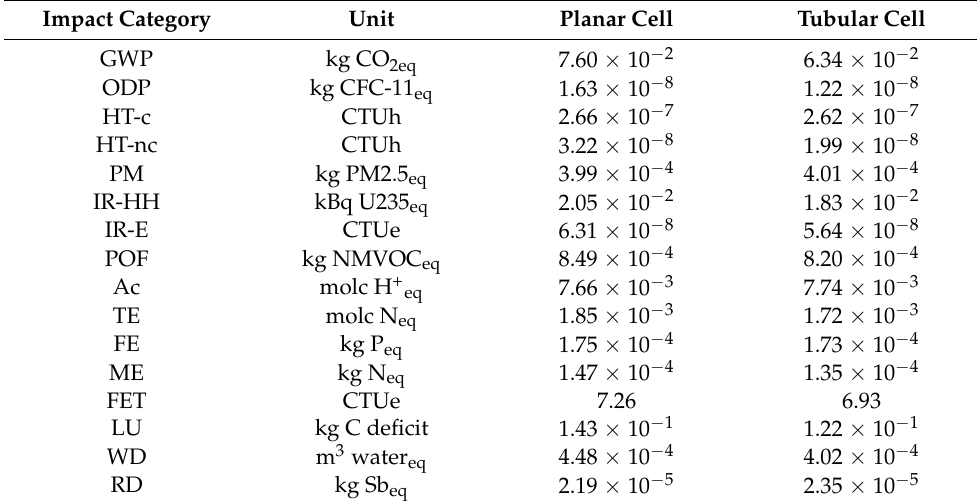
Table 4. Environmental impacts of the two examined configurations (data for 1